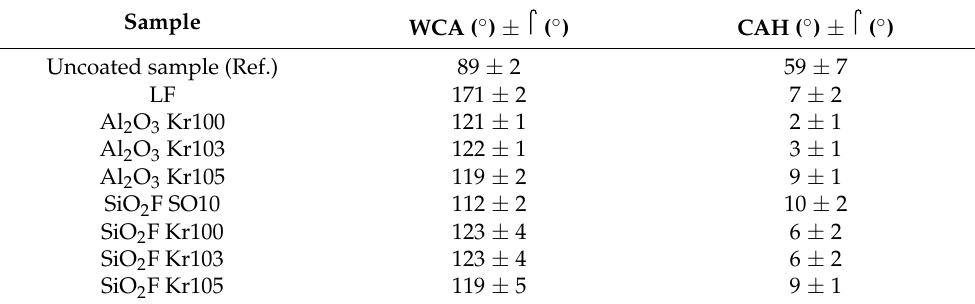
Table 2. Average static contact angle with water (WCA) and contact angle hysteresis (CAH) at T amb . Sample